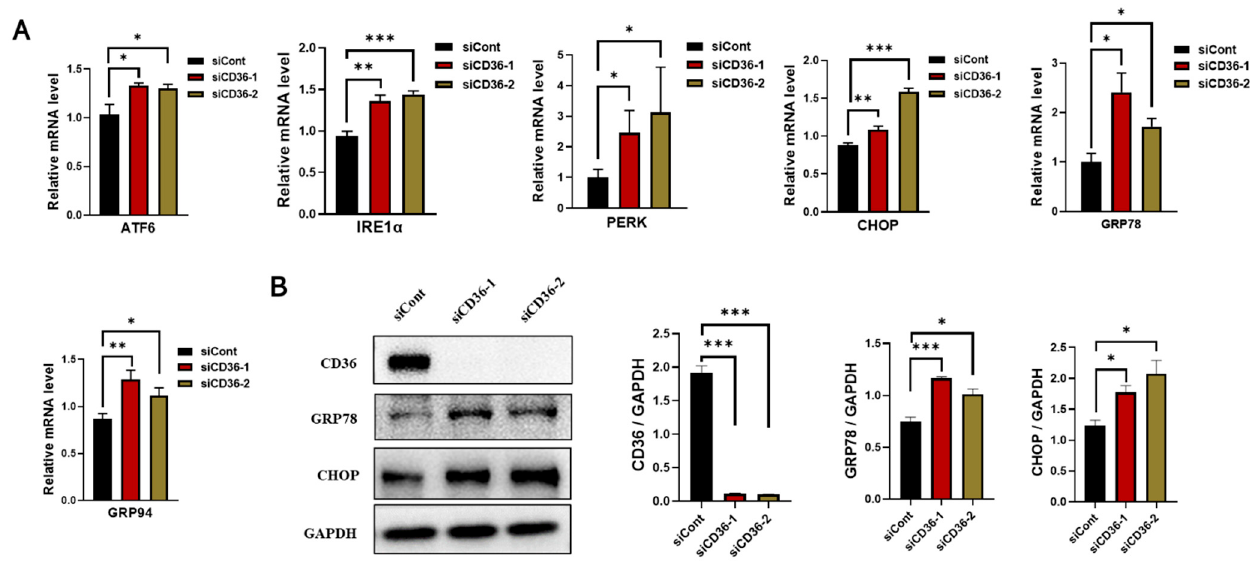
Figure 4. Loss of CD36 enhances ER stress in C2C12 myotubes without PA loading. ( A ) Expression of genes involved in ER stress (ATF6, IRE1 α , PERK, CHOP, GRP78, and GRP94) as examined by RT-PCR in C2C12 myotubes with or without CD36 knockdown. ( B ) Western blot analysis and quantification of CD36, GRP78, and CHOP expression detected by western blot analysis in C2C12 myotubes with or without CD36 knockdown. Each protein expression level was normalized to that of the GAPDH gene. Values are presented as the mean ± SEM of three independent experiments. * p < 0.05, ** p < 0.01, *** p < 0.001 versus the siCont group.